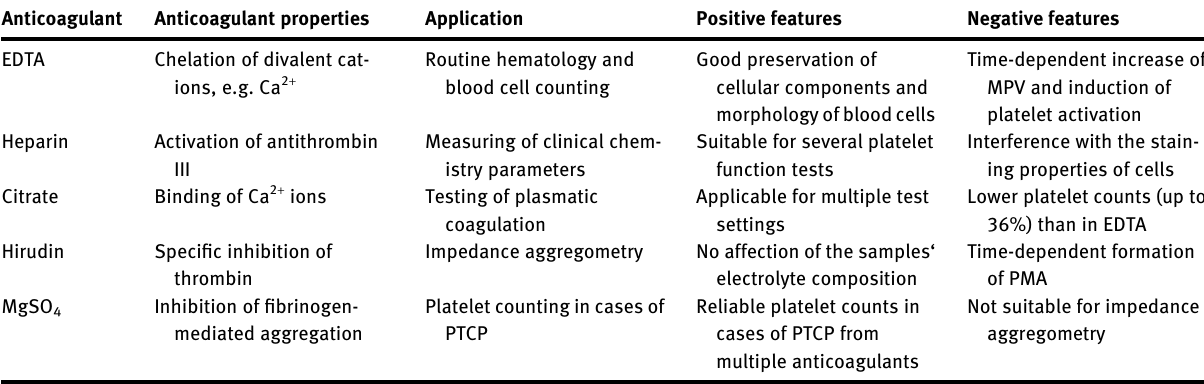
Table  : Properties of different routineously applied in vitro anticoagulants.